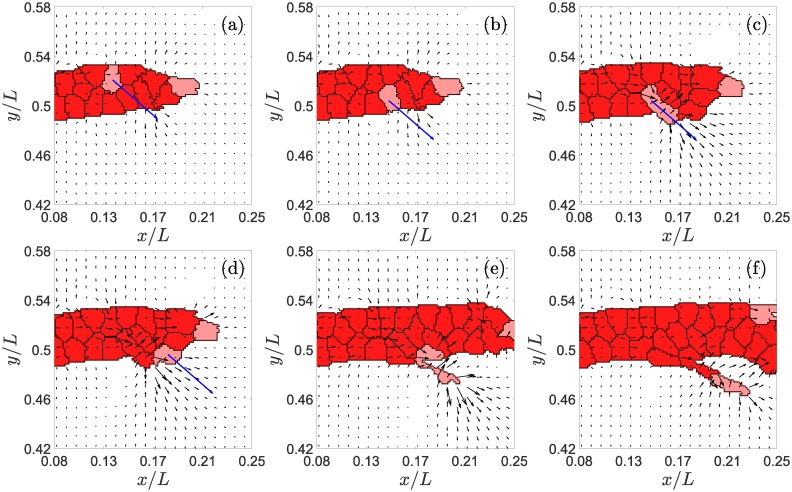
Example of tip cell exchange and branching in the direction of the blue arrow.Times in MCTS are: (a) 422, (b) 423, (c) 460, (d) 461, (e) 545, (f) 630. The black arrows in this figure represent the directions of largest eigenstrain and, therefore, they point to the likeliest direction of EC motion. The blue arrows indicate the actual direction of motion of a selected tip cell (marked in pink color) for the simulation we have carried out.